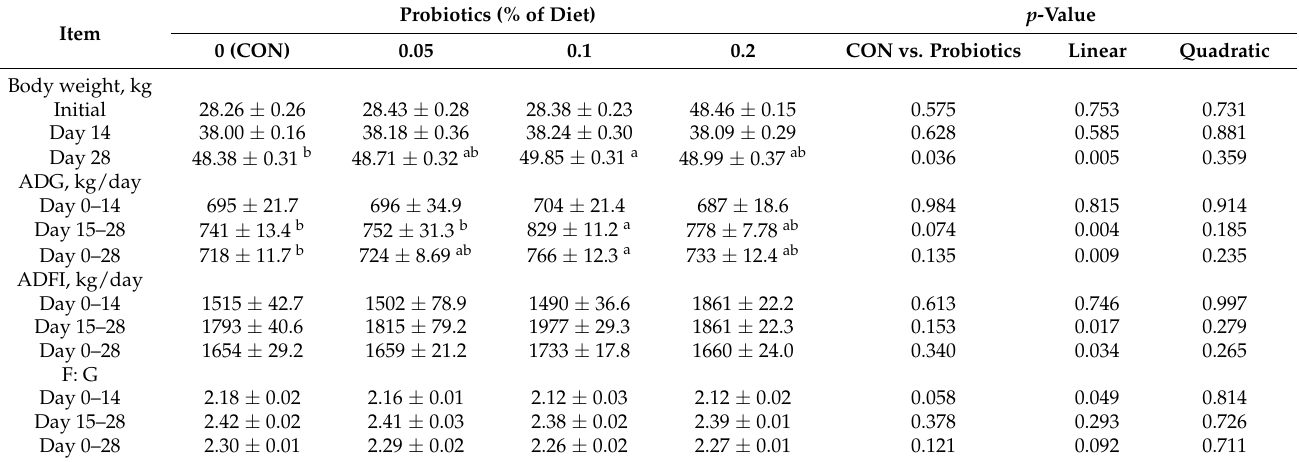
Table 3. Effects of dietary complex probiotic supplementation on growth performance in growing pigs.